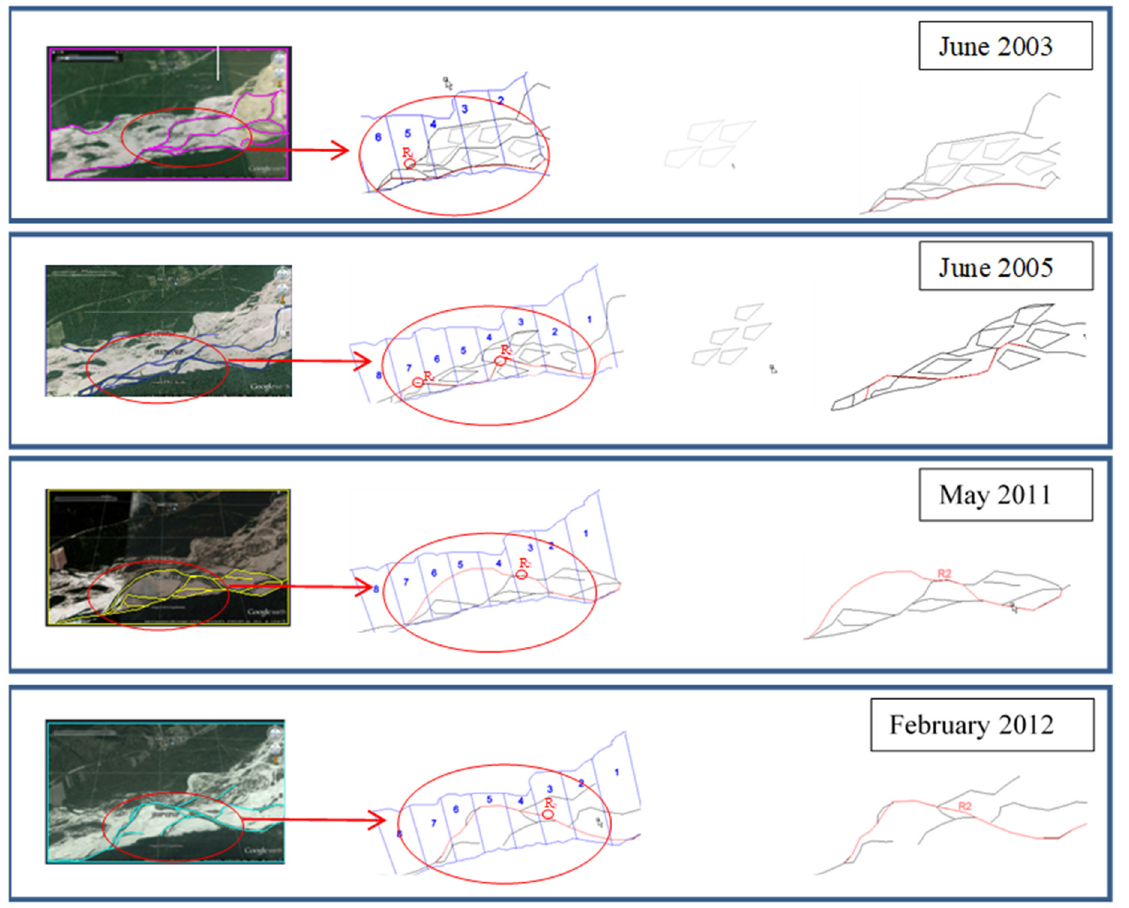
Figure 8. Morphological features and evolution from June 2003 to February 2012 (images obtained from Google Earth, Image ©2015 DigitalGlobe).